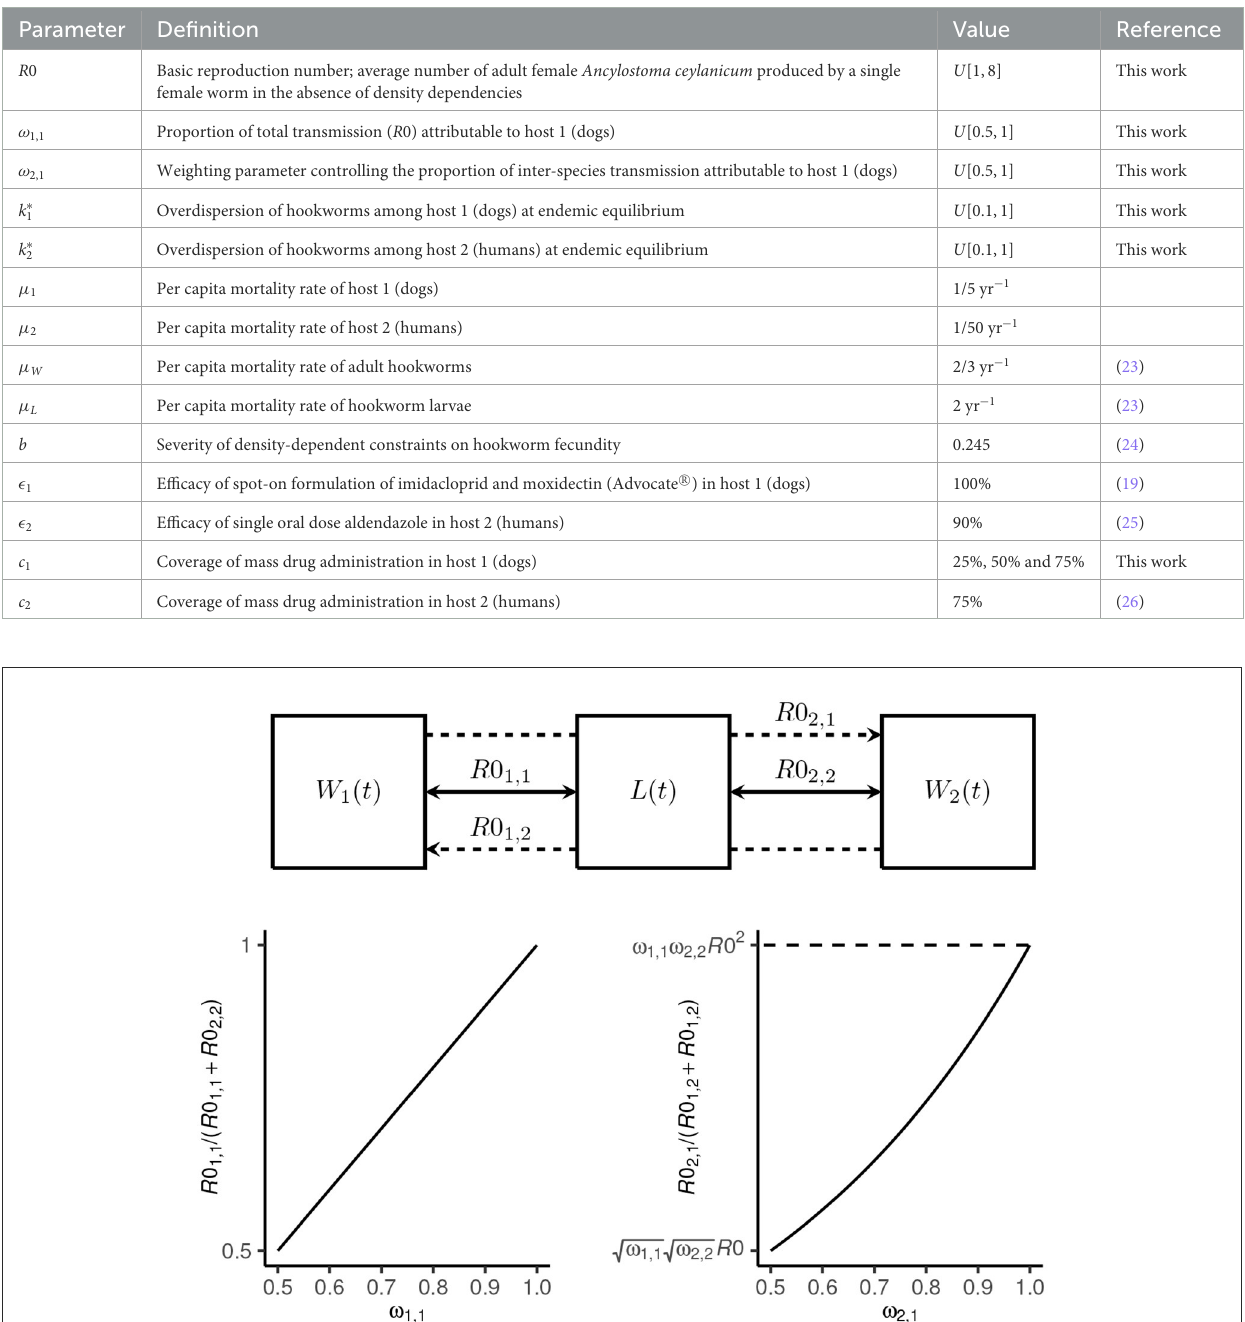
TABLE 1 Parameter definitions and values.